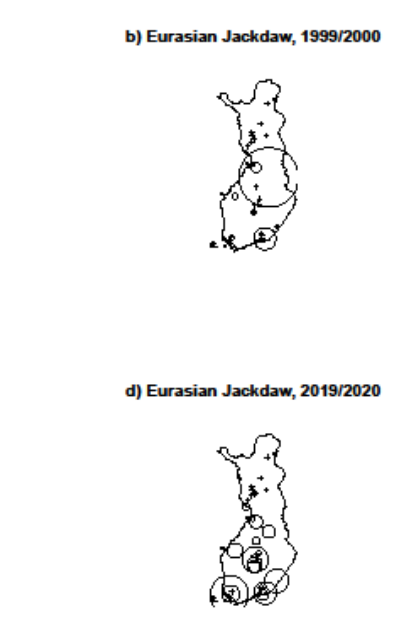
Figure 1. Distribution maps of Eurasian Jackdaw populations in 31 study sites during the winters of 1991/1992 ( a ), 1999/2000 ( b ), 2009/2010 ( c ) and 2019/2020 ( d ) in Finland. The size of the circle indicates the number of individuals. The smallest circle indicates one individual, and the largest circle 111 individuals. The symbol (+) indicates lack of observation during a specific winter within a specific study site.